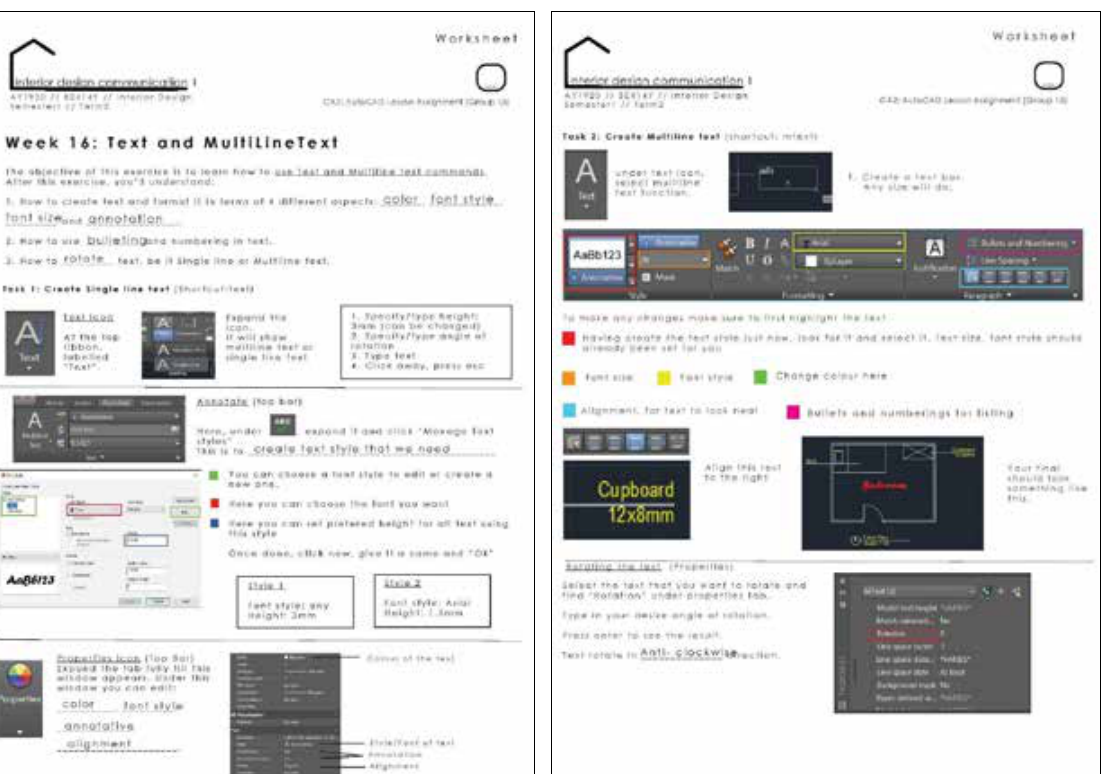
Figure 9: Sample completed participant worksheet. Source: